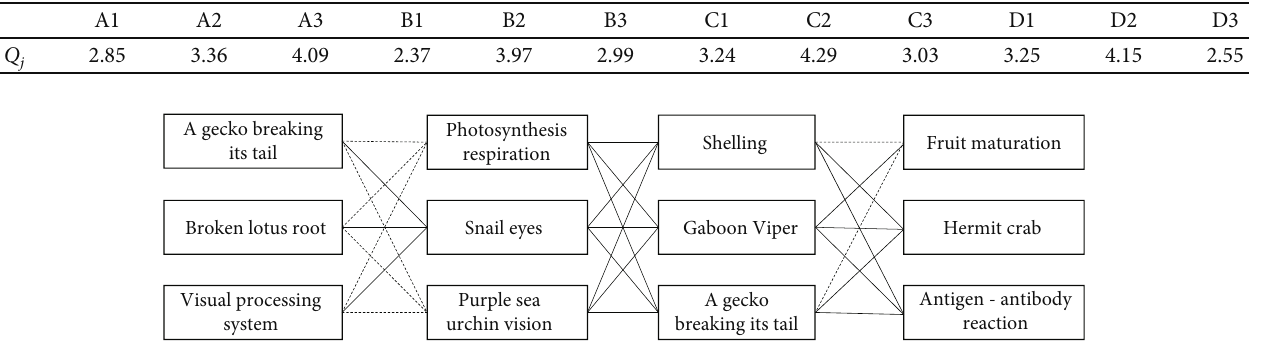
Table 5: The collation of the data of the biological prototype scores.